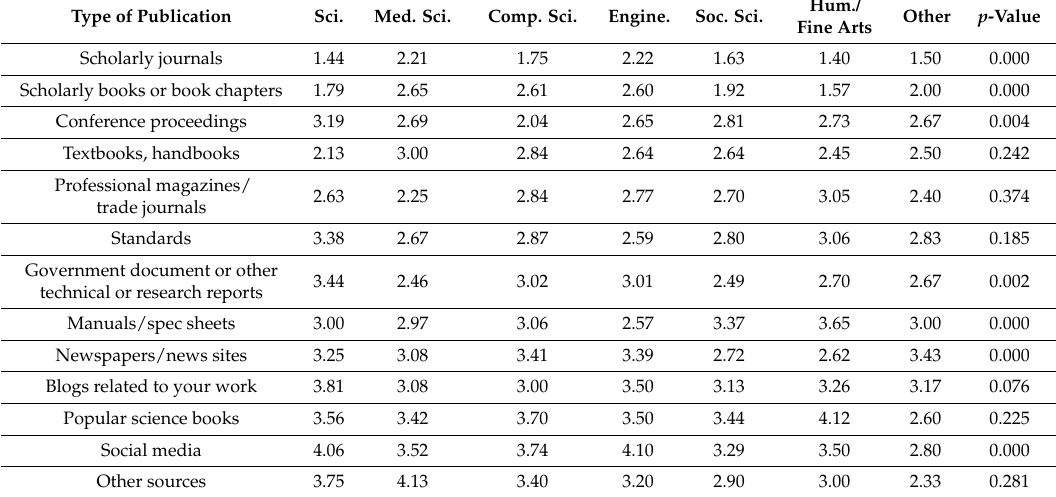
Table 5. Importance of types of publications to respondents’ work (1 = absolutely essential; 2 = very important; 3 = important; 4 = somewhat important; 5 = not at all